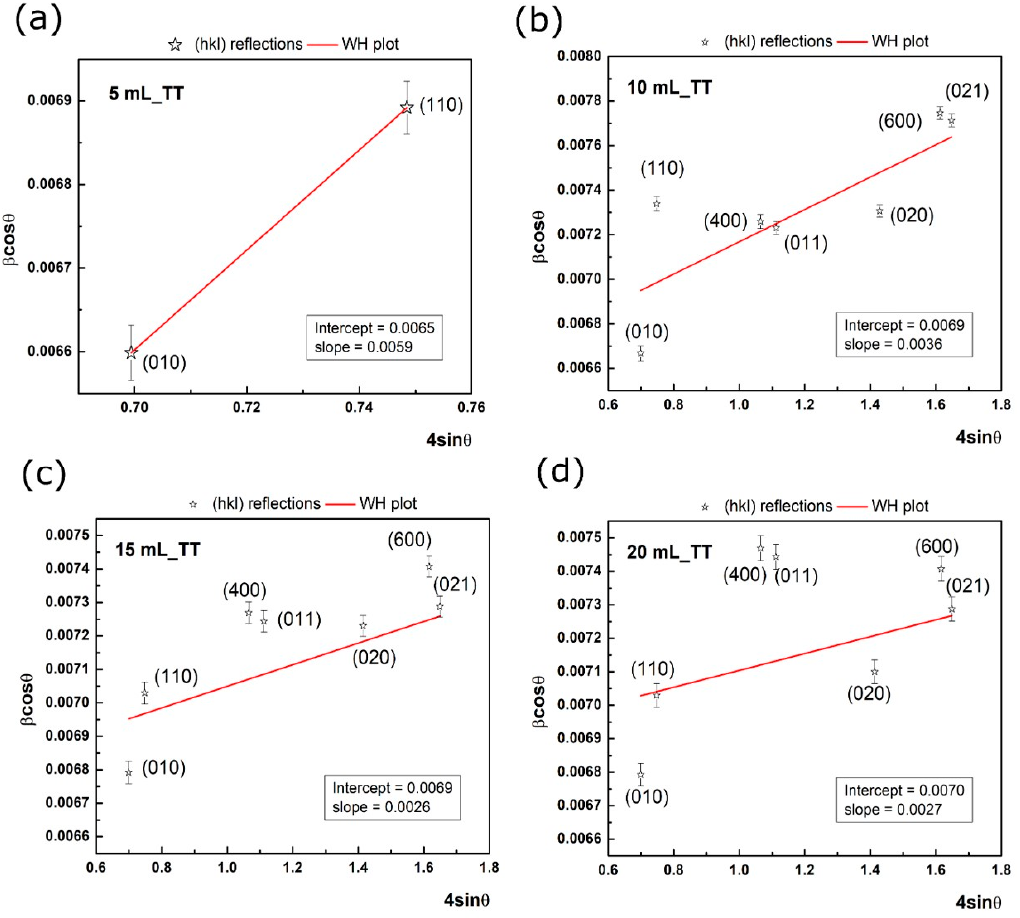
Figure 2. Williamson-Hall plot for: ( a ) 5 mL after annealing, ( b ) 10 mL after annealing, ( c ) 15 mL after annealing, and ( d ) 20 mL after annealing with red line. The values of the intercept and slope are listed in the inset.